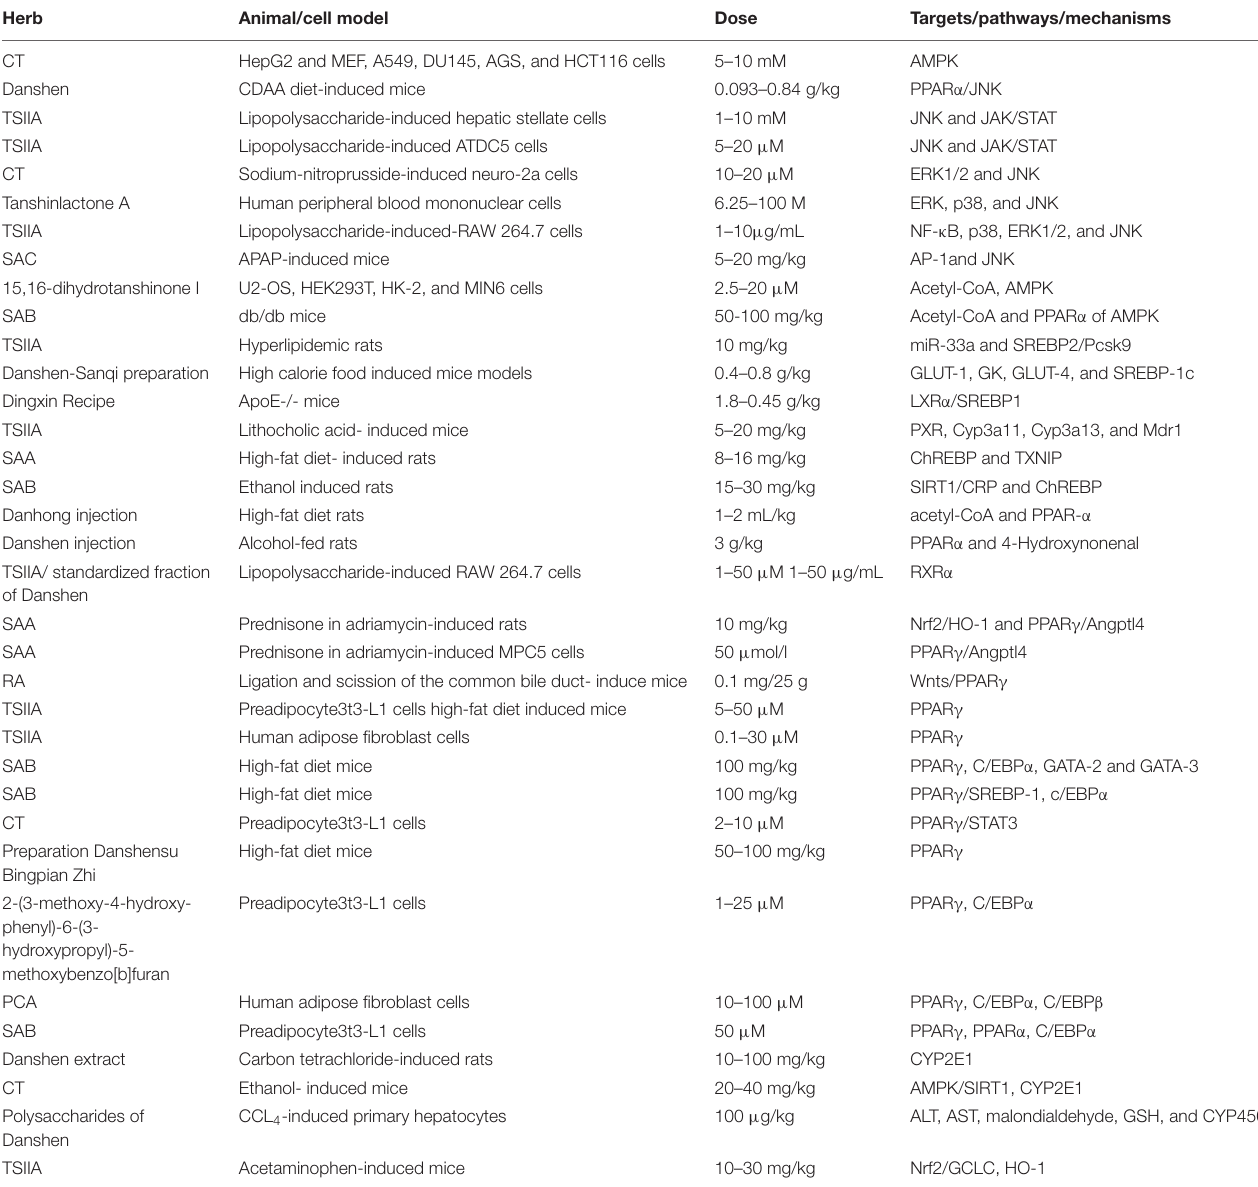
TABLE 1 | The metabolic targets involved in treating NAFLD of